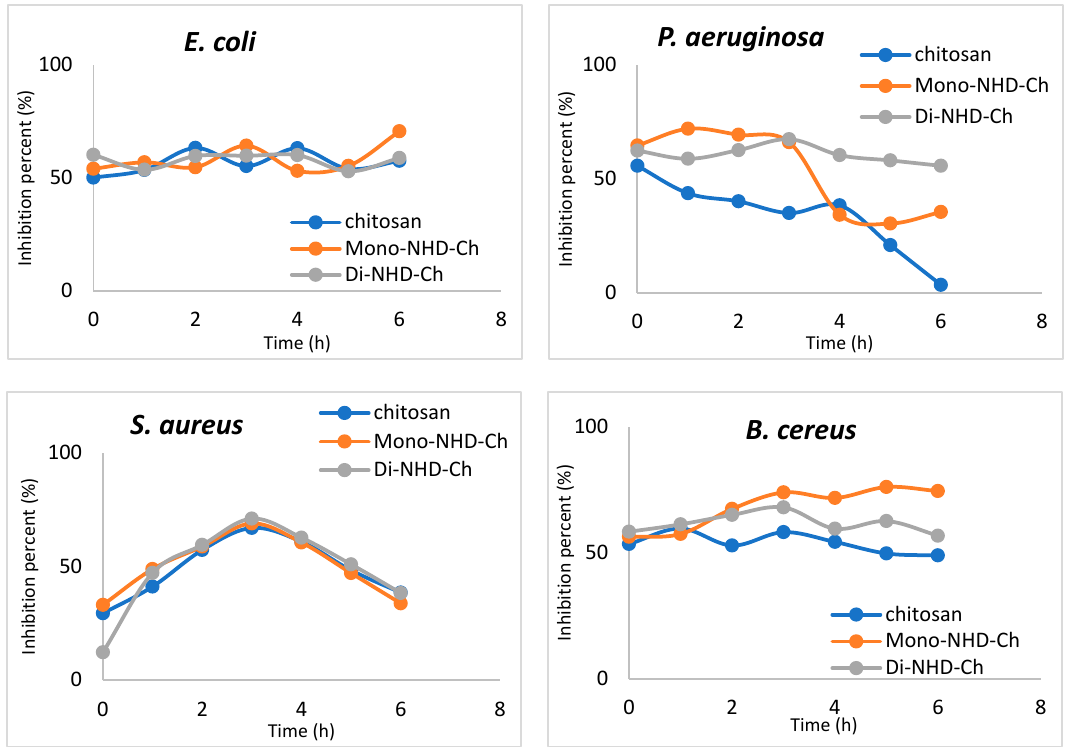
Figure 4. Bactericidal activity of chitosan and its alkyl derivatives (Mono-NHD-Ch and Di-NHD-Ch) against E. coli , P. aeruginosa , B. cereus , and S. aureus .